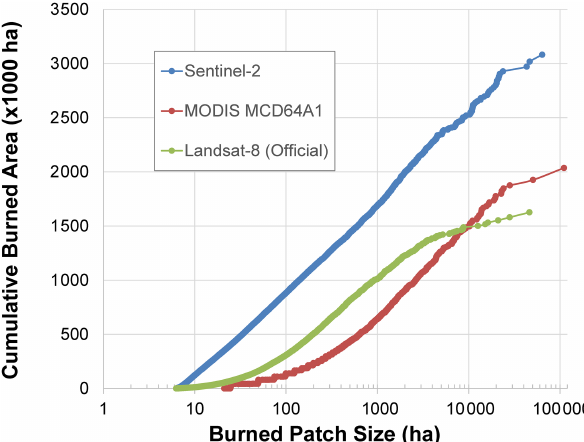
Figure 6. Cumulative national total burned area vs. burned-scar area, for Sentinel-2, Landsat 8 (official), and MODIS MCD64A1 burned-area estimates. Note the logarithmic axis. For a given seg- ment of the x axis between scar sizes X 1 and X 2 , a difference in the slopes for any two estimates is indicative of inter-estimate dif- ferences in terms of inclusivity of scars between X 1 and X 2